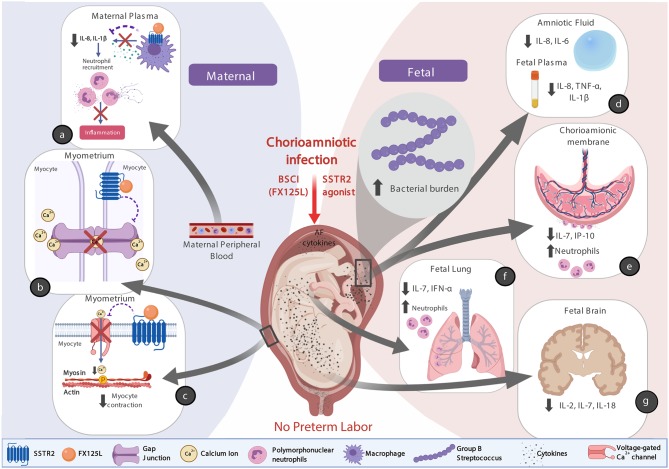
A conceptual model showing how BSCI (FX125L) can prevent PTL, but allow for neutrophilic infiltration into placental chorioamniotic membranes and fetal lungs. We show the maternal (a) and fetal (d–g) effects of BSCI, as well as proposed mechanisms of BSCI action on the myometrium (b,c). In the BSCI +GBS group compared to the GBS only group, the major neutrophil chemokine IL-8 and pro-inflammatory cytokine IL-1β were reduced in the maternal plasma (a) and pro-inflammatory cytokines were inhibited in amniotic fluid and the fetal plasma (d), chorioamniotic membranes (e), fetal lungs (f), and fetal brain (g) tissues compared to GBS alone. BSCI administration did not prevent GBS-associated neutrophil recruitment into the fetal membranes and fetal lung (e,f). The simultaneous progression of infection into the fetal compartment represents a serious adverse outcome for the pregnancy. Note that this figure was created with Biorender.com.